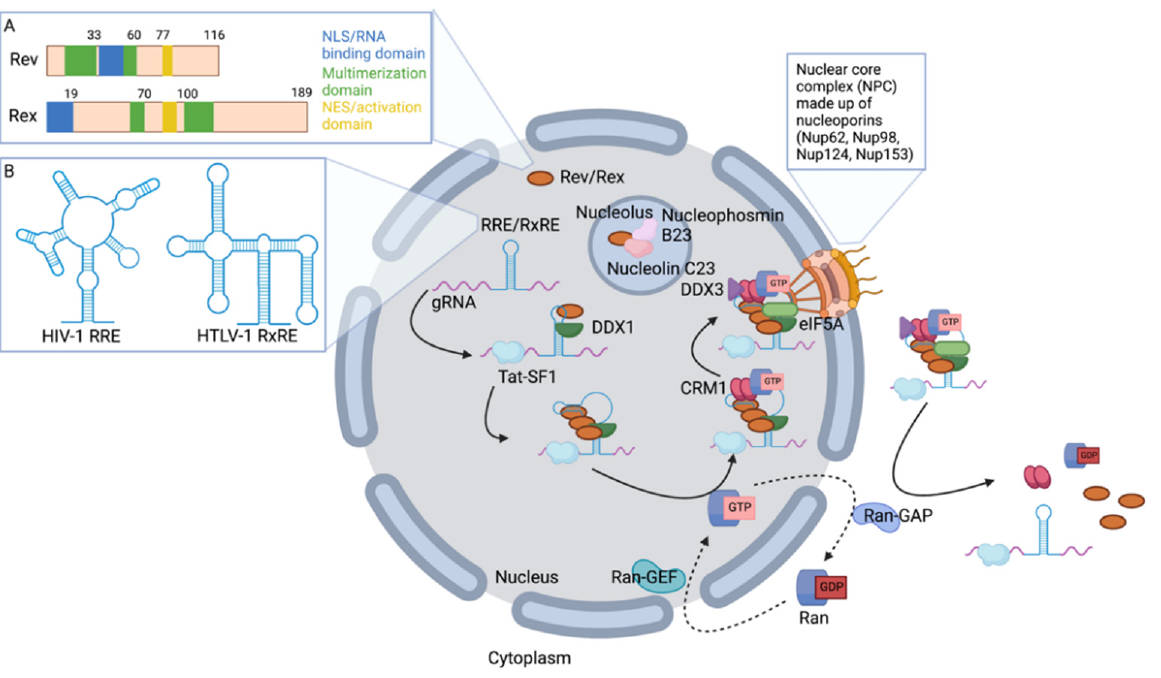
Figure 1. Nuclear export of human retroviral gRNA. ( A ) . The mapped domains in the HIV-1 Rev and HTLV-1 Rex proteins. Nuclear localization signal (NLS) Nuclear export signal (NES) ( B ). The secondary structure of the HIV-1 RRE and HTLV-1 RxRE. Rev responsive element (RRE) Rex respon- sive element (RxRE) See text for further details. Note that the RRE and RxRE structures are not drawn to scale. DEAD box helicase 1 (DDX1), DEAD box helicase 3 (DDX3), HIV Tat-specific factor 1 (Tat-SF1), Chromosomal Maintenance 1, also known as Exportin 1 (CRM1), Ras-related Nuclear protein (Ran), Ran Guanine nucleotide exchange factor (Ran-GEF), Ran GTPase activating protein (Ran-GAP), Eukaryotic translation initiation factor 5A (eIF5A). Created with BioRender.com soft- ware (accessed on 4 May 2022).